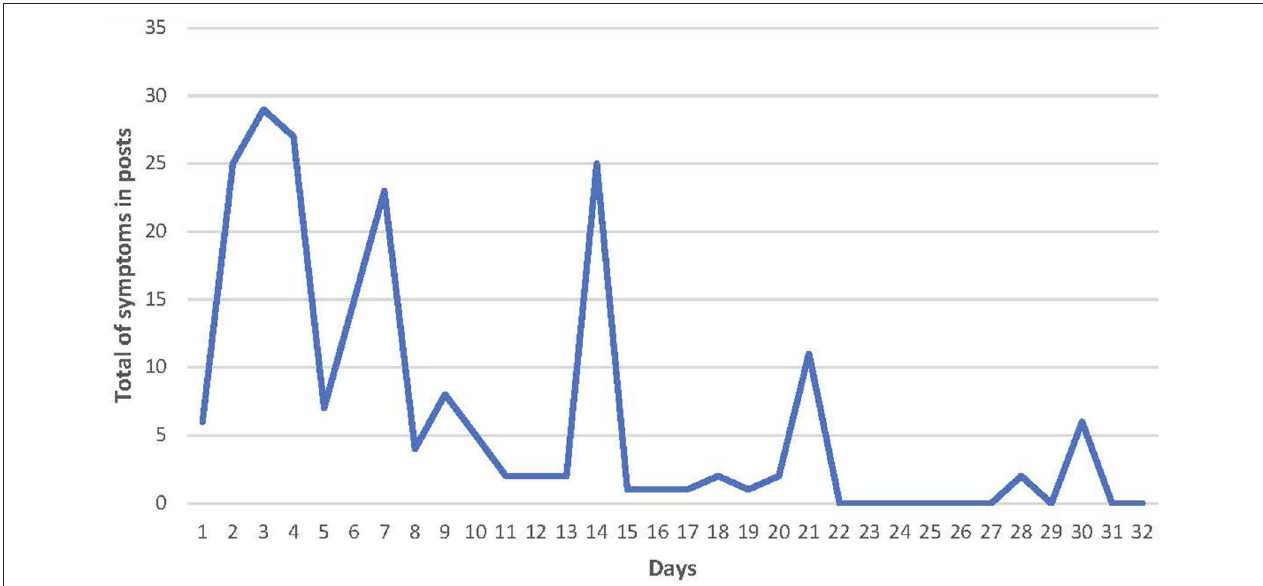
FIGURE 1 | Histogram of the reported time course of onset of symptoms of keto